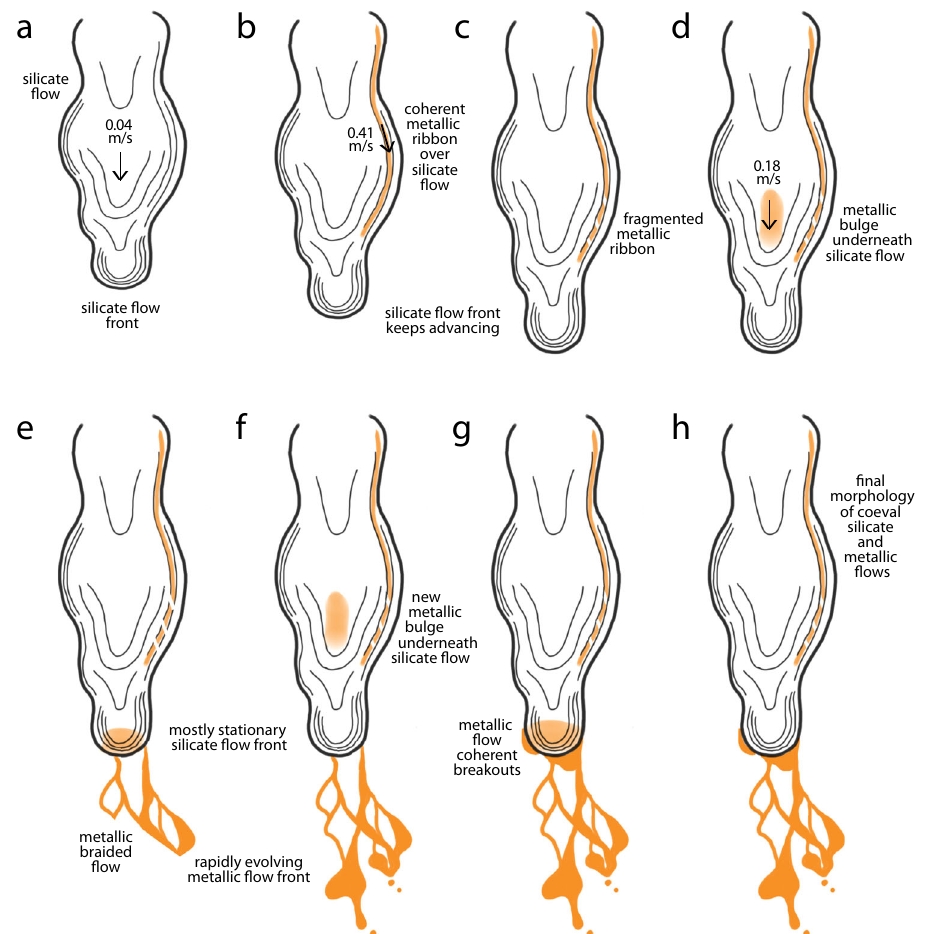
Fig. 1 Flow emplacement. a Silicate sheet, ropey fl ow advancing at 0.04 m/s. b Metallic ribbon (yellow) emplaced at 0.41 m/s over the silicate fl ow, following its ropey surface texture; c metallic ribbon being dismembered as the surface of advancing silicate fl ow deforms. d Metallic bulge (yellow patch) traveling underneath the silicate fl ow, with mixed- fl ow velocity of 0.18 m/s. e Metallic bulge reaching the silicate fl ow front and violently breaking out from it, emplacing a braided metallic fl ow; d , e are repeated. f Third metallic pulse traveling underneath the silicate fl ow. g Last metallic bulge gently breaking out from the silicate fl ow front emplacing a few coherent metallic breakouts. h Final morphology of the co-emplaced silicate and metallic fl ows: the silicate fl ow is a coherent, ropey sheet, whereas the metallic fl ow body is partly lumpy and cohesive and partly braided and not fully coherent; the metallic fl ow front extends past the silicate fl ow